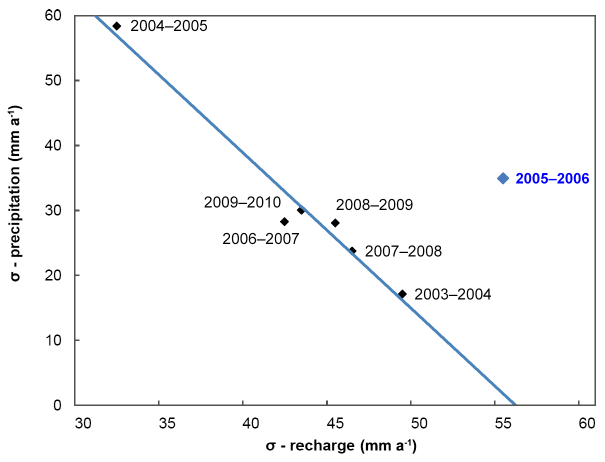
Figure G1. The axes are the scaling of standard deviations ( σ ) of P and DP. Note that the linear trend line excludes the year 2005– 2006, which deviates from the trend of the other years. In this year, spatial variability of recharge was quite high but nonetheless, spa- tial variability of recharge was high as well. 2005–2006 was a spe- cial year because it had an exceptionally intensive storm event (and the strongest during the entire measurement period) very late in the season (early April 2006). The different stations were affected dif- ferently by the relatively long dry period before the event and the high precipitation during the event, depending on the soil thickness and therefore on the speed of the drying of the soils and consequent soil saturation during the